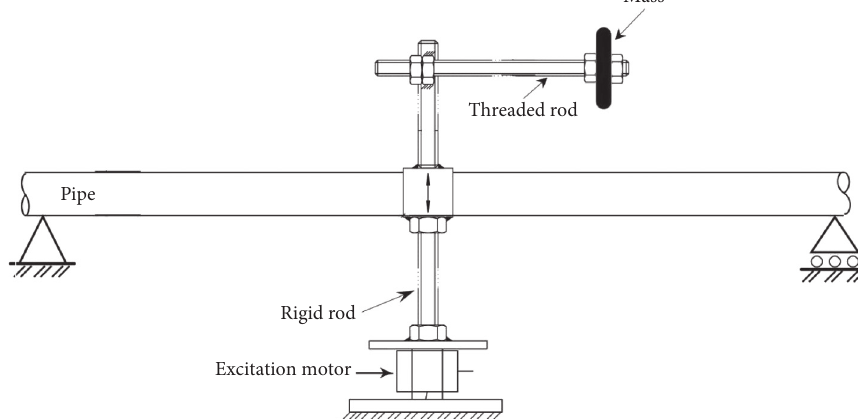
Figure 1: Schematic of the pipeline structure and beam DVA.